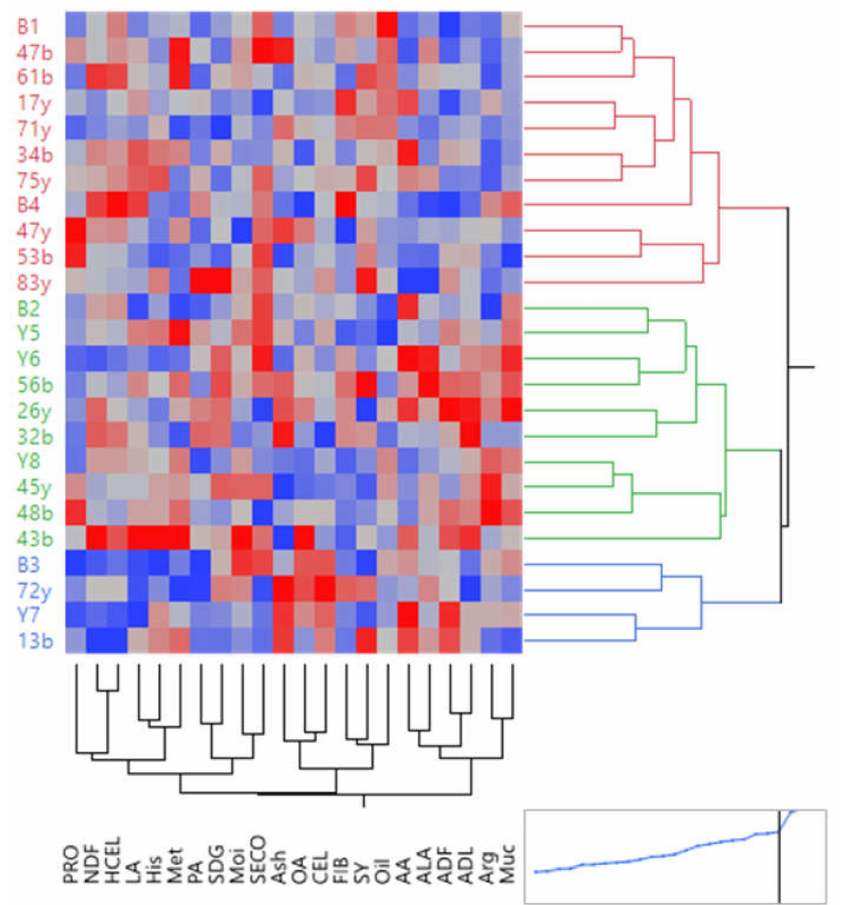
Figure 6. Heat-mapping diagram related to the studied traits of flax families under normal conditions. The dark blue color indicates the lowest value of the characters, and the dark red color indicates the highest value. SY: seed yield. Oil: oil content. NDF: neutral detergent fibers. ADF: acid detergent fibers. ADL: lignin. CEL: cellulose. HCEL: hemicellulose. Muc: mucilage. PRO: protein content. FIB: fiber content. OA: oleic acid. LA: linoleic acid. PA: palmitic acid. ALA: α - Linolenic acid. Met: methionine. His: histidine. Arg: arginine. AA: aspartic acid. Moi: moisture. SDG: secoisolariciresinol diglucoside. SECO: